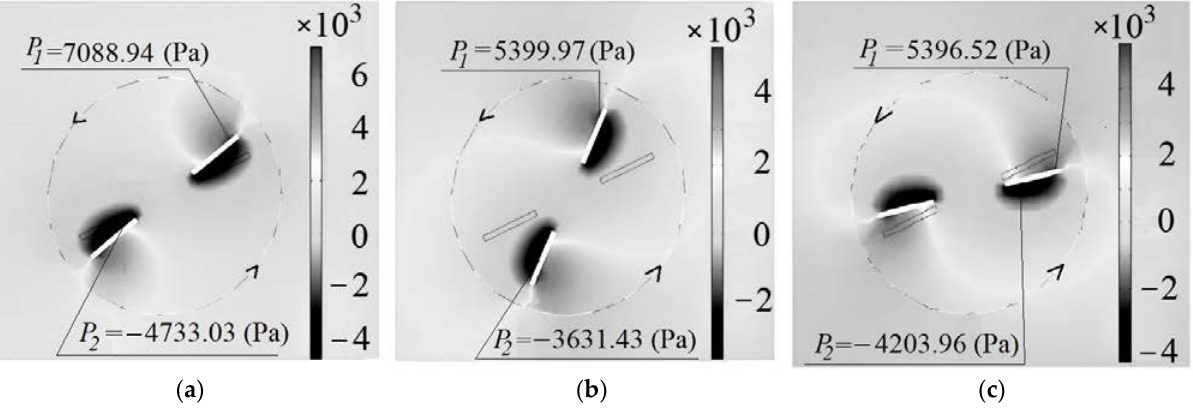
Figure 5. Calculation pressure in fluid behind the stirrer paddles for rotational speed n = 1000 (rpm) and paddle height h = 0.05 (m) at the calculation time T (s): ( a ) 1, ( b ) 4, ( c ) 6.